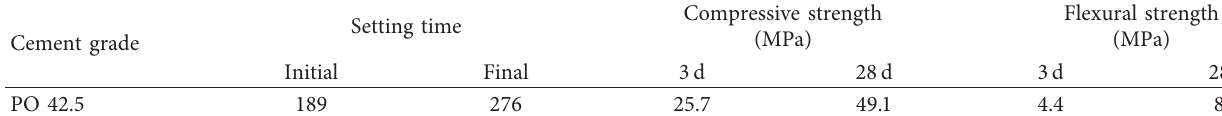
Table 3: Properties of Portland cement PO 42.5.